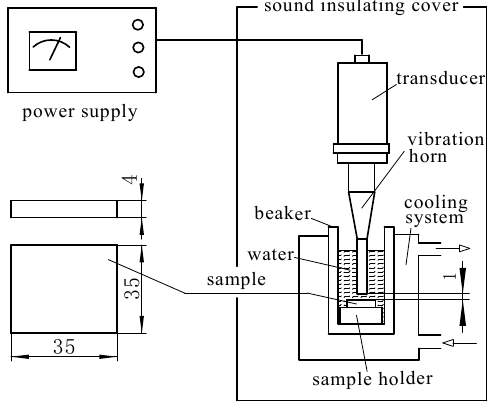
Figure 1. Schematic of vibratory cavitation test rig.